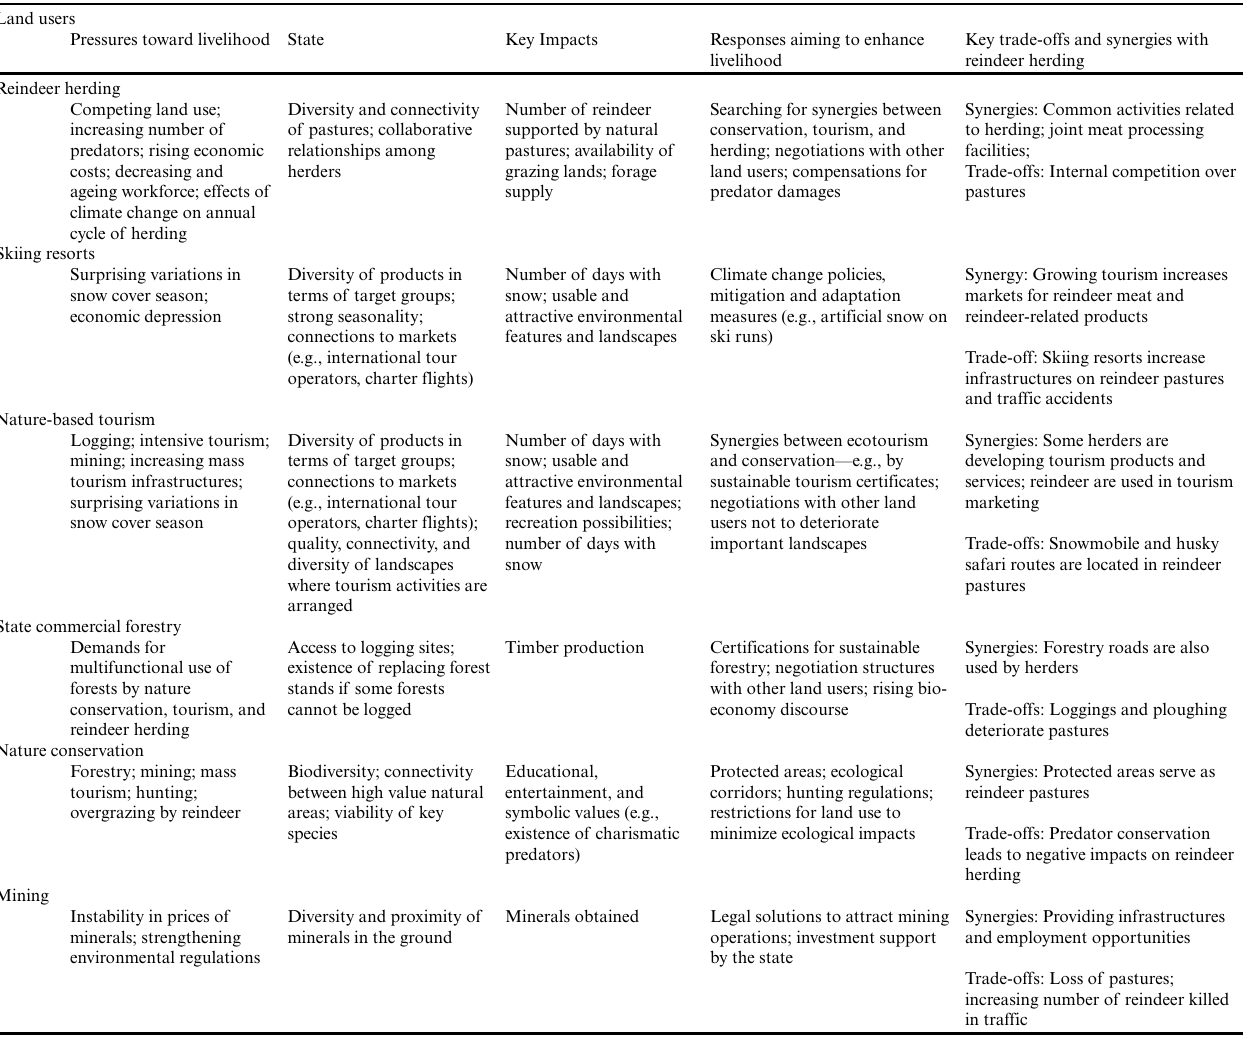
Table 2 . Overview of DPSIR factors for various land users related to Pressures, State, Impacts, Responses, and their relationships to reindeer herding in Northern